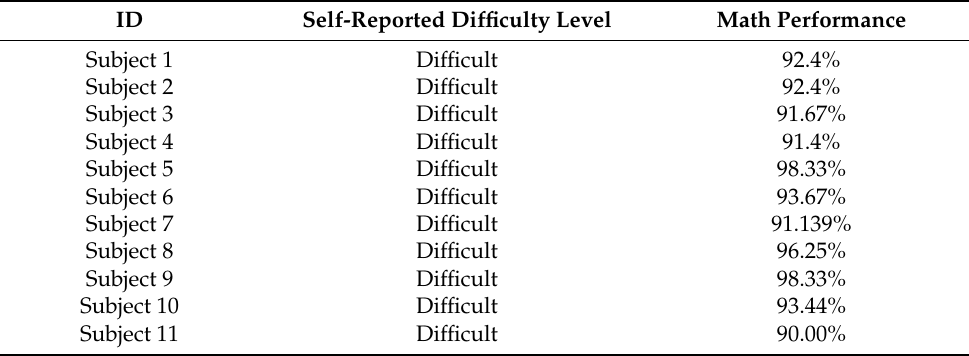
Table 3. Summary of the participants’ self-reported level of difficulty as well as math